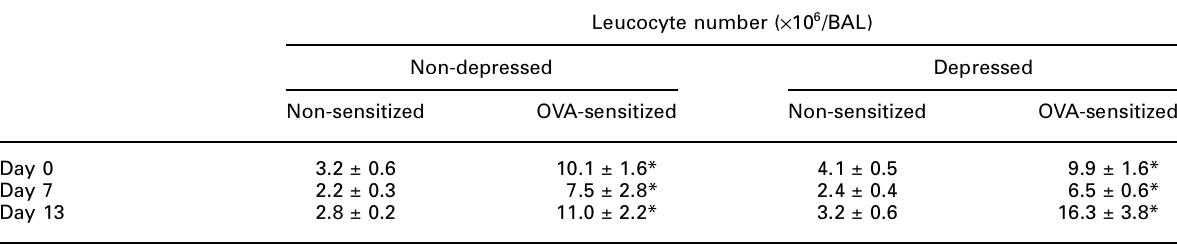
Table 1. Total leukocyte counts in BAL fluid from both non-depressed (non-sensitized and sensitized) and depressed (non- sensitized and sensitized) rats in response to intratracheal injection of OVA (0.4ml of 0.25% ovalbumin solution) Leucocyte number ( ´ 10 6 /BAL)